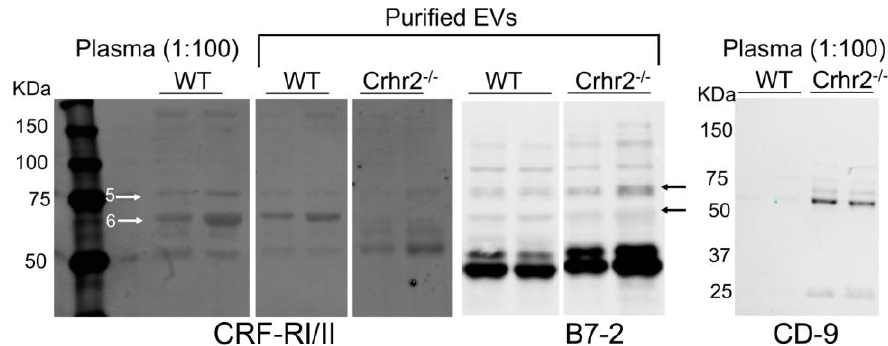
Figure 2. CRF receptors in murine plasma and purified EVs. Representative immunoblots showing CRFR expression and CD9+ EVs in plasma (1:100 diluted) of wild-type (WT) and Crhr2 null mice. Purified EVs from serum show similar CRFR banding pattern in WT mice, whereas Crhr2 null lacked bands at positions 5 and 6 (arrows) that were also seen in human plasma. B7-2 was detected at its expected size of ~75KDa and other bands that overlapped with CRFR, suggesting cargo-related changes in weights and sizes of EVs.